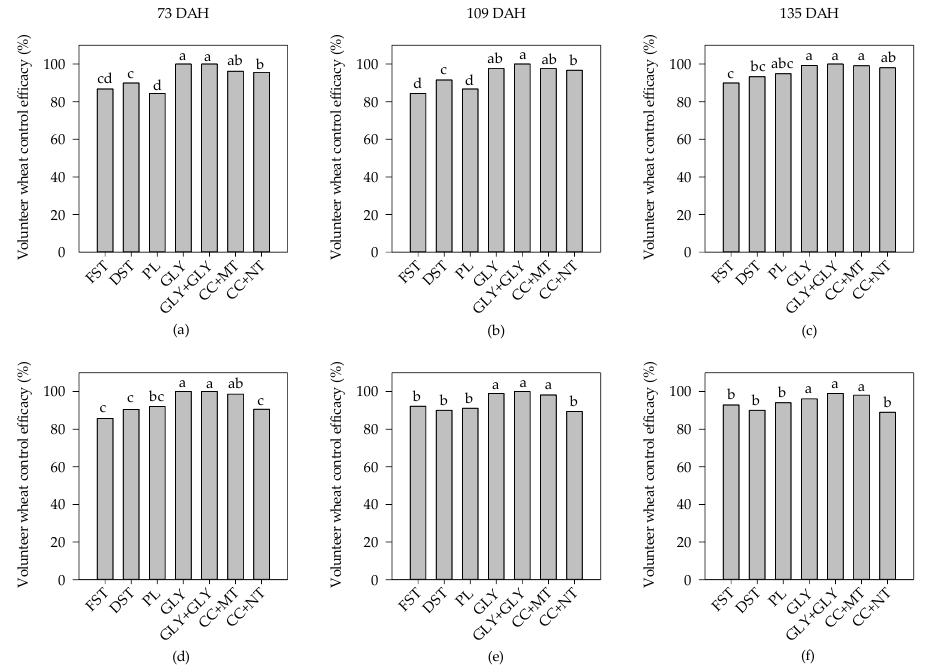
Figure 3. Average volunteer wheat control efficacy of flat soil tillage (FST), deep soil tillage (DST), ploughing (PL), single glyphosate application (GLY), dual glyphosate application (GLY+GLY), cover crop mixture + mulch-till (CC+MT), and cover crop mixture + no-till (CC+NT) treatments at the two trials at the fields ( a – c ) Binsen and ( d – f ) Risp. ( a , d ) 73, ( b , e ) 109, and ( c , f ) 135 days after harvest (DAH). Different small letters within one graph show significant differences according to the Tukey–HSD test ( p ≤ 0.05). Means with identical letters do not differ significantly.